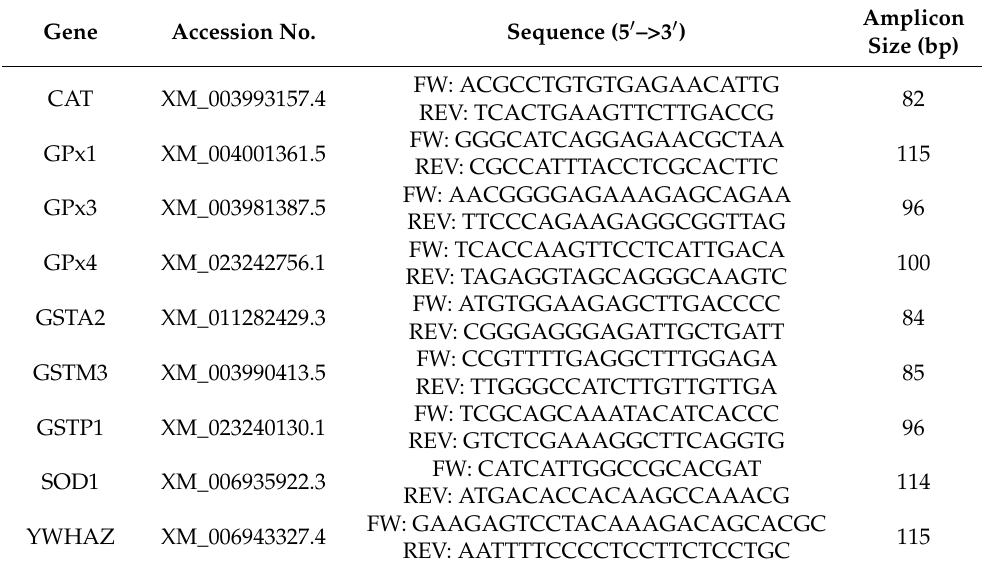
Table 1. Primers for quantitative RT-PCR